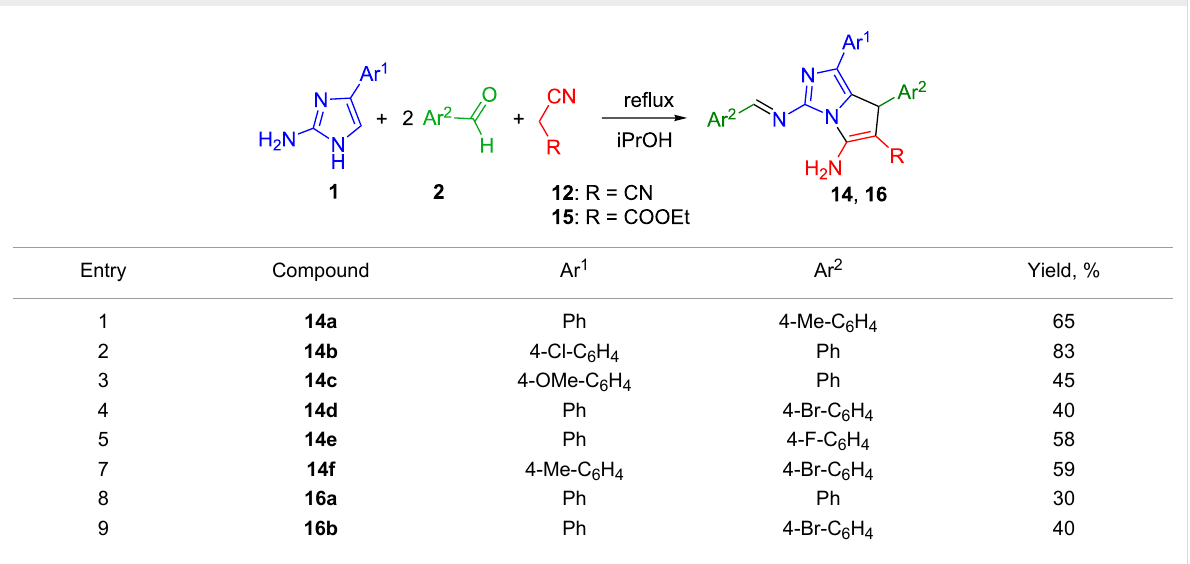
Table 3: Synthesis of compounds 14 and 16